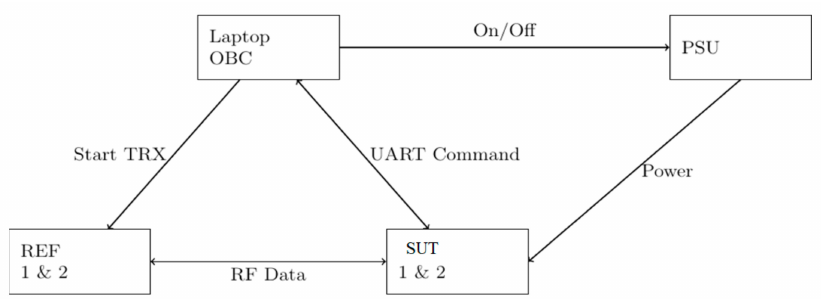
Figure 6. Control and data flow of the GSDR test setup.